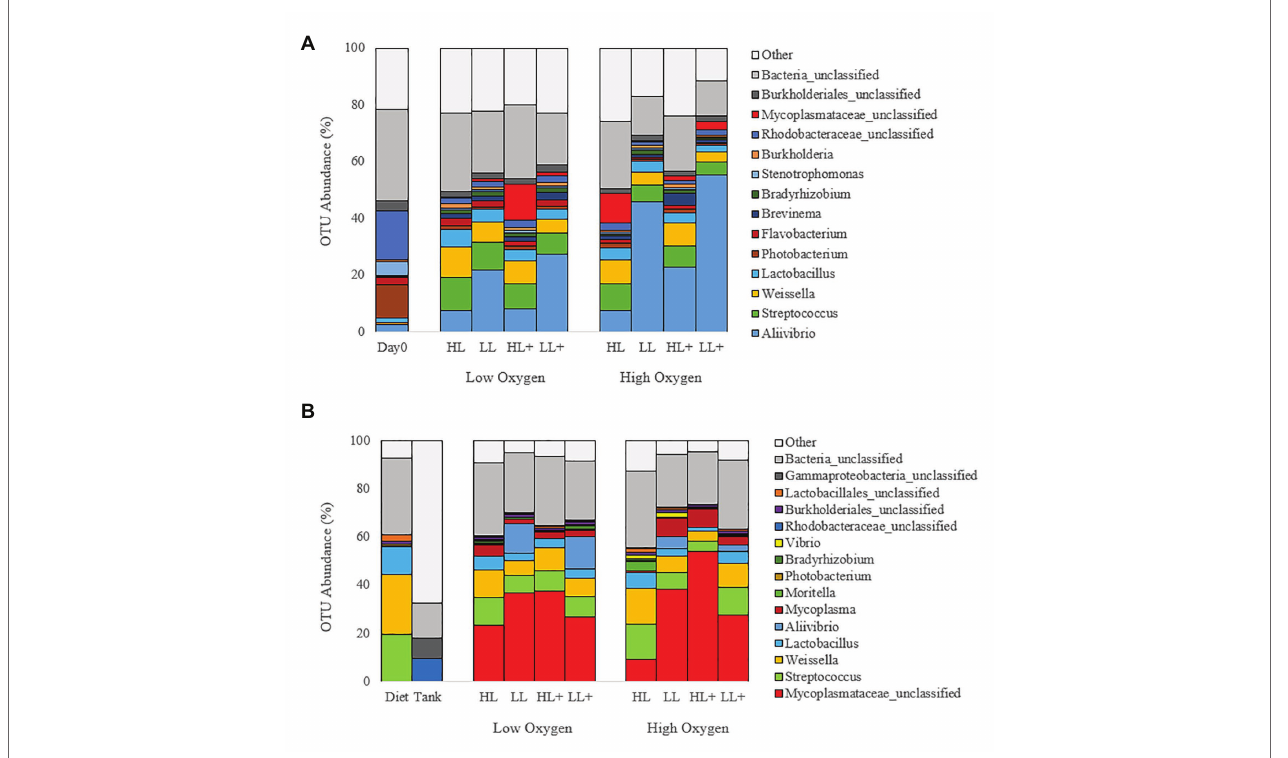
Phyla Order Genus Diet p -value Actinobacteria